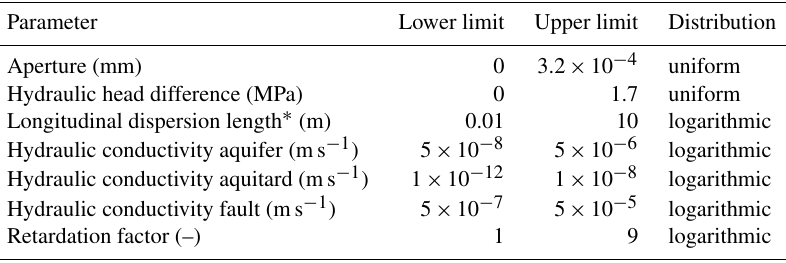
Table 3. Parameter variations applied in the uncertainty analysis. Seven input parameters were varied in 512 simulations based on Sobol’s Quasi-Monte-Carlo (QMC) sampling method.